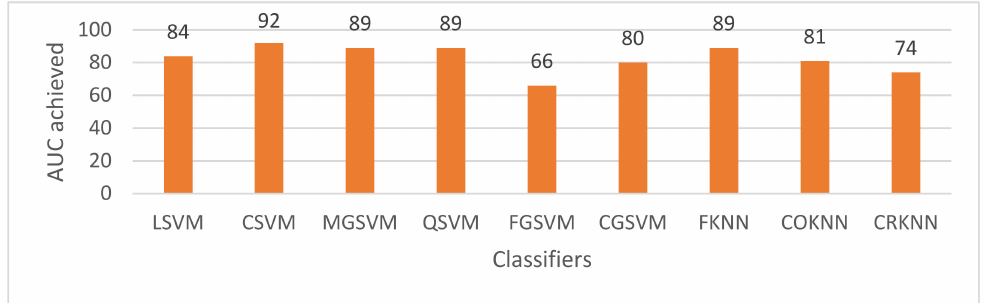
Figure 19. Comparison in terms of AUC with various classifiers on mixed views of MIT dataset using 1000-feature